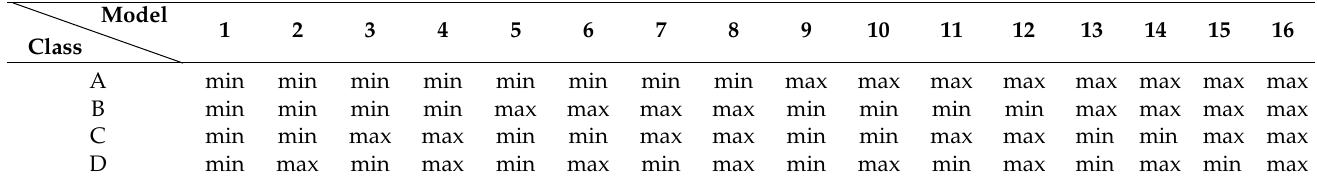
Table 6. The design matrix for the two-level full factorial design with four classes.